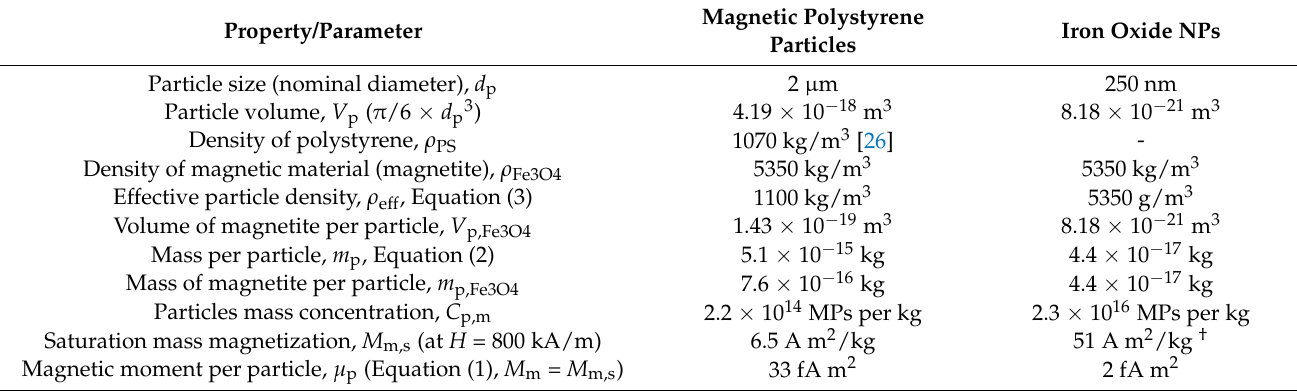
Table 1. Properties of magnetic particle samples